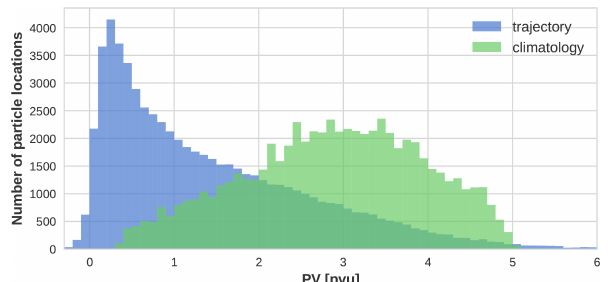
Figure 10. Probability density distributions of PV values for the Pa- cific particles (blue) and for the climatological values interpolated to their two-dimensional locations (green). The former is based on 10.1% of the Pacific particles that reached above 400hPa and whose potential temperature remains between 300 and 320K in the last 4d before arriving at the Euro-Atlantic blocks, while the latter is based on the CFSR climatological PV values at the 310K level computed by applying a 30d low-pass filter. The two distributions are significantly different at the 95% confidence level.